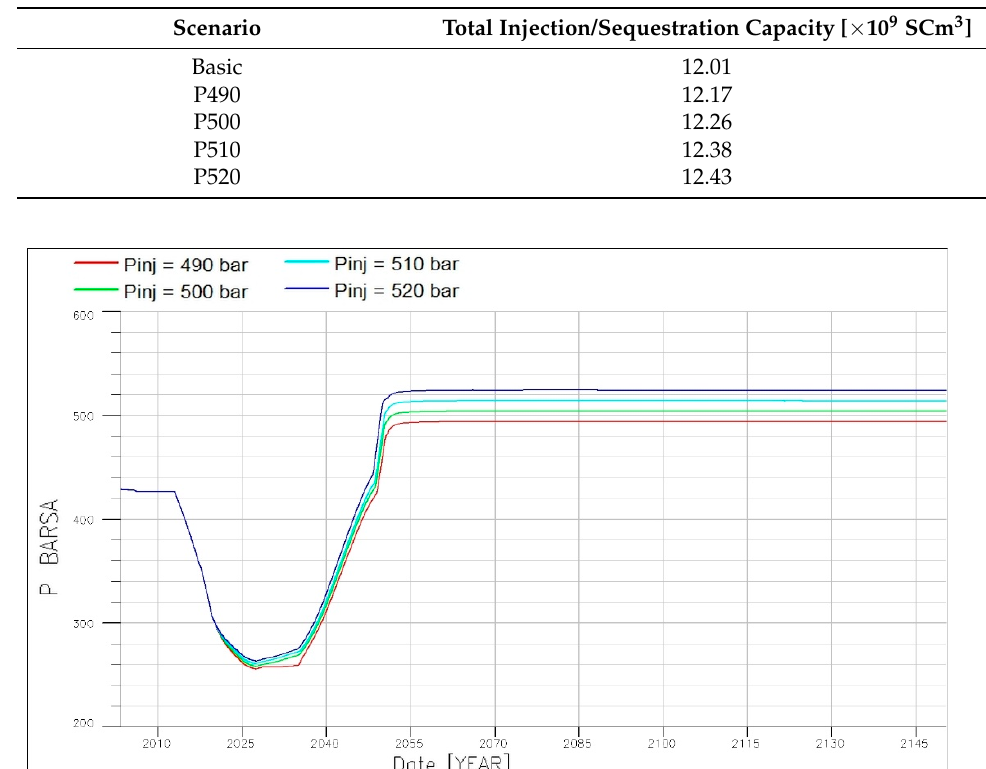
Figure 25. Average reservoir pressures for various injection scenarios.